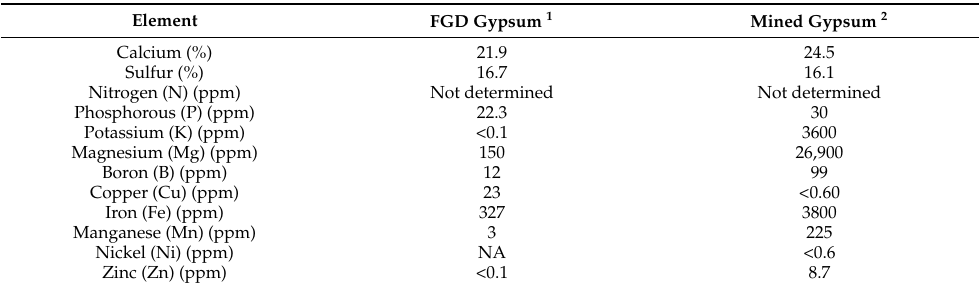
Table 1. Elemental composition of flue gas desulfurization (FGD) gypsum, a byproduct of coal-fire electrical utility plants, and mined